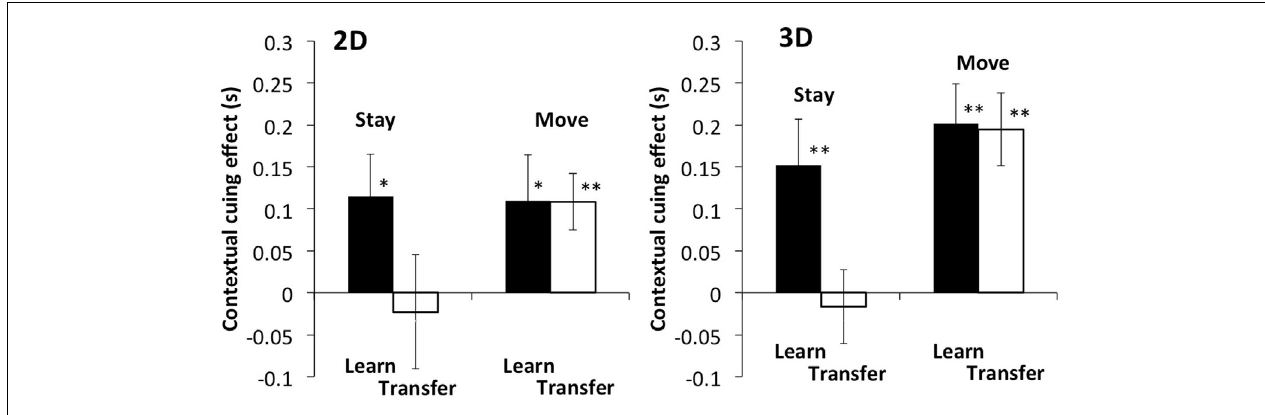
epochs in the transfer phase. Error bars represent standard error across participants. Asterisks and pluses are used to show the results of a one tail t -test for the difference between the novel and repeated layout: ** for p < 0.01, * for p < 0.05, and + for p < 0.1 (the same in Figures 5 , 7 and 9